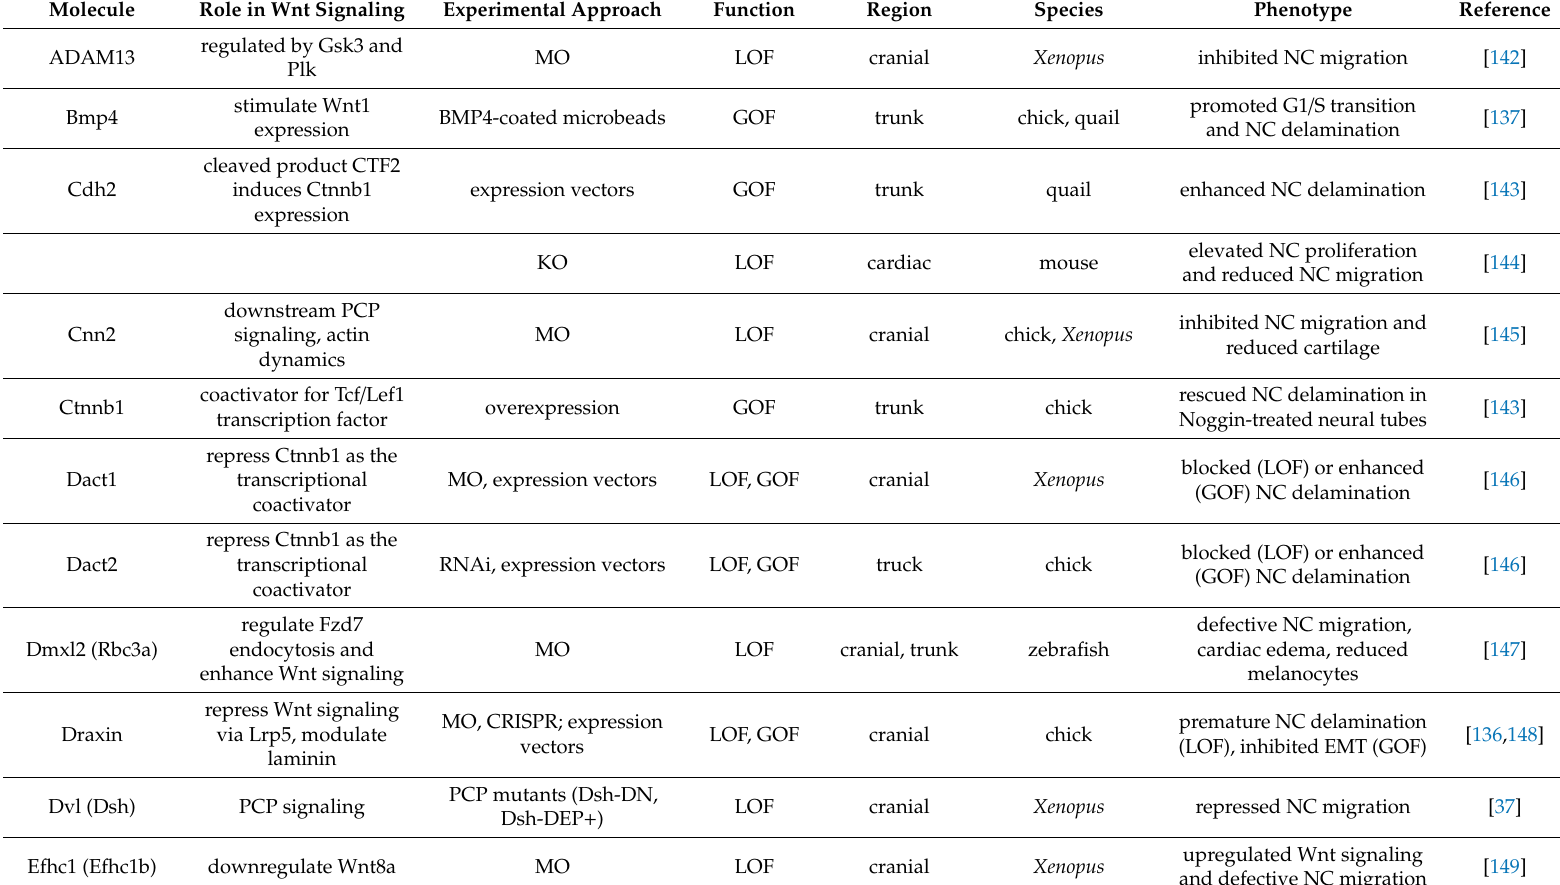
Table 2. Experimental findings of Wnt signaling molecules, modulators, and e ff ectors in vertebrate neural crest delamination and migration. (cKO, conditional knockout; EMT, epithelial-mesenchymal transition; GOF, gain of function; KO, knockout; LOF, loss of function; MO;